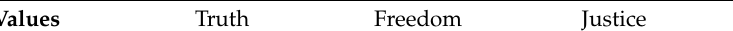
Table 2. Values of the SDC.